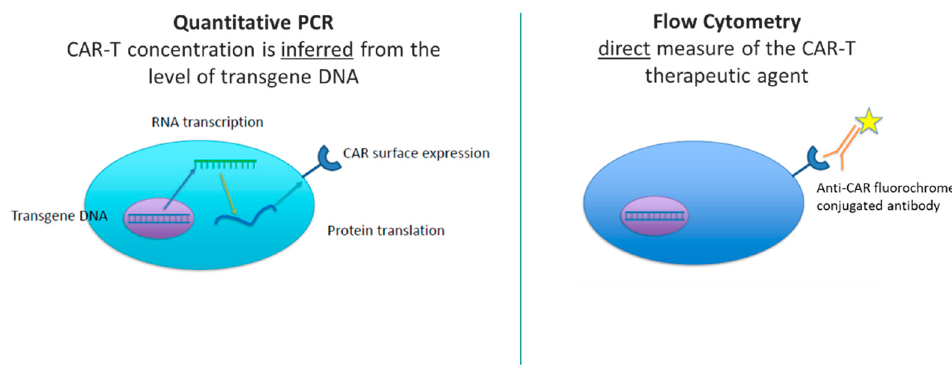
Figure 1. Schematic of CAR-T Detection by qPCR and Flow Cytometry.